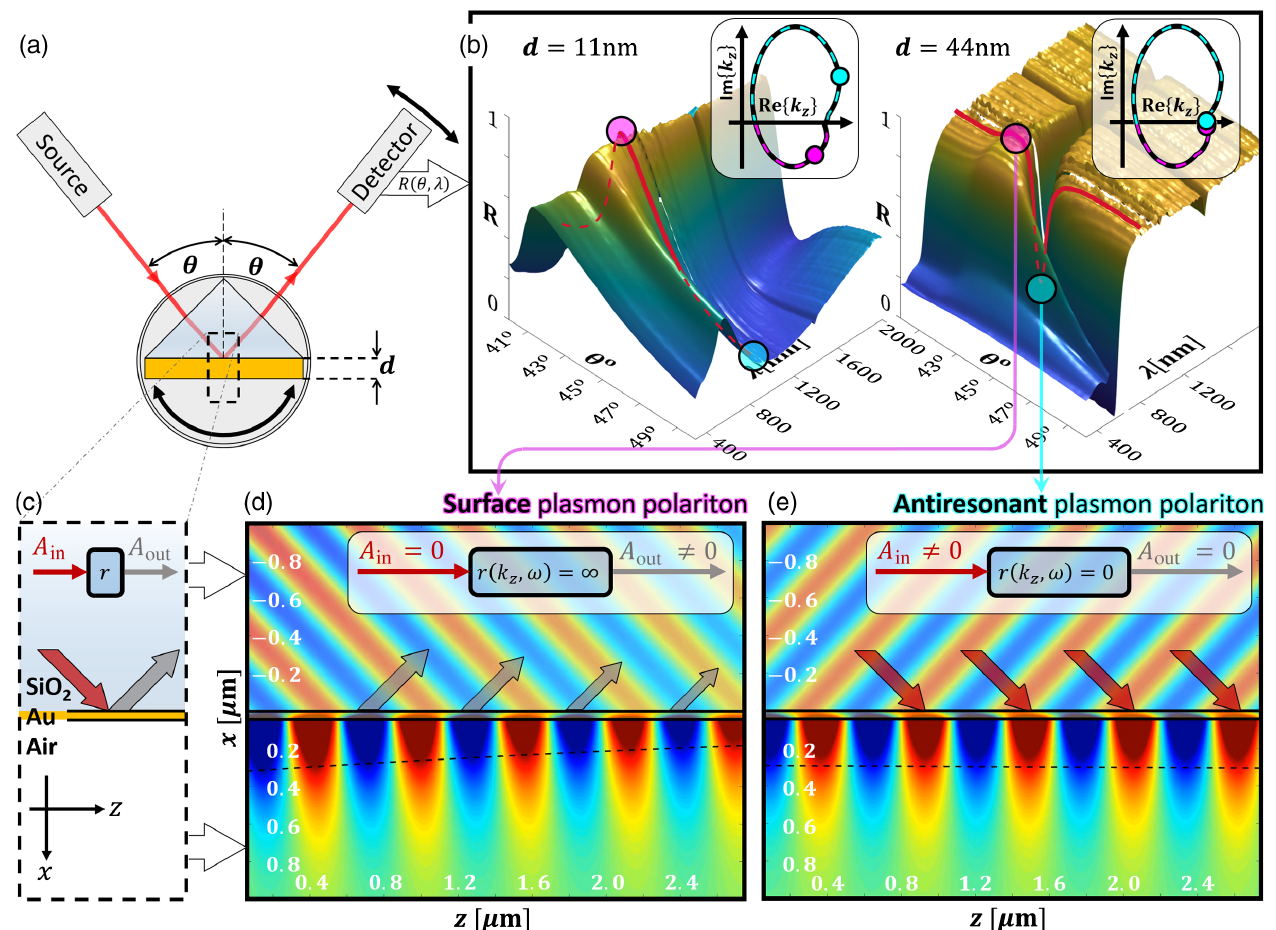
FIG. 1. Experimental concept: controlling pair excitations of modal (SPP) and nonmodal (APP) plasmons. (a) Schematic measurement setup: ATM-polarized beam impinges upon a thin gold film via a glass coupling prism, and the reflected beam is collected for various incidence angles θ and illumination wavelengths λ . (b) SPP-APP pair excitations make the measured reflectance R exhibit a tunable peak-and-dip line shape ( λ ¼ 800 nm, red curves), ranging from spectrally and angularly wideband absorption for ultrathin films (11 nm) to the narrow asymmetric Kretschmann dip for thicker films (44 nm). Inset: Locations of the APP and SPP wave vectors k z (cyan and magenta circles) along their root locus (dashed line) as the film thickness changes. (c) Incident ( A ( A , gray arrow) wave amplitudes at the front gold-glass interface are related by the reflection coefficient r , the transfer function of a out linear space-time invariant system (block diagrams). (d),(e) Calculated magnetic fields of the SPP and APP ( d ¼ 44 nm, λ ¼ 600 nm), time dynamics shown in Movie 1. Inset: SPPs and APPs assigned to system resonances ( r ¼ ∞ ) and antiresonances ( r ¼ 0